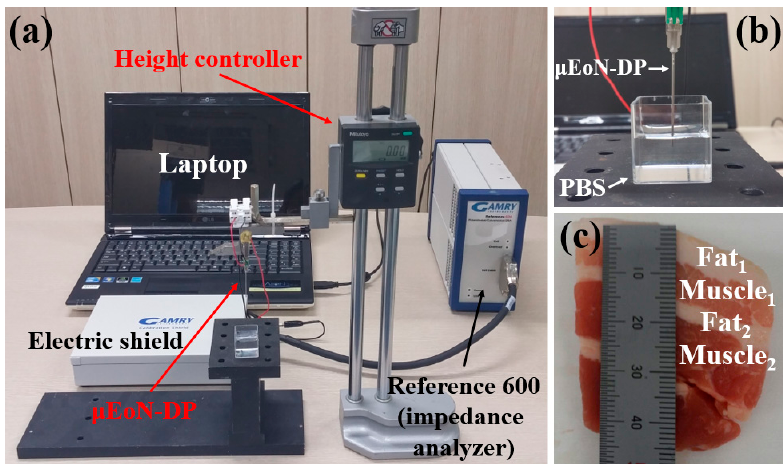
Figure 2. Images of experimental setup: ( a ) overall setup; ( b ) μ EoN-DP immersed in the PBS; and ( c ) four-layered porcine tissue.